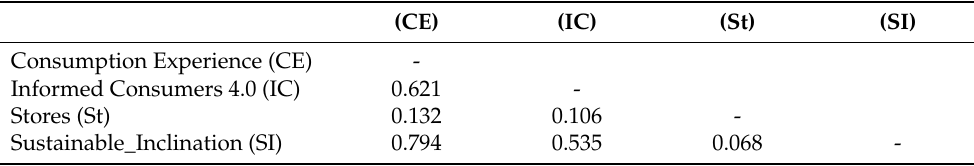
Table 6. Heterotrait–Monotrait results.